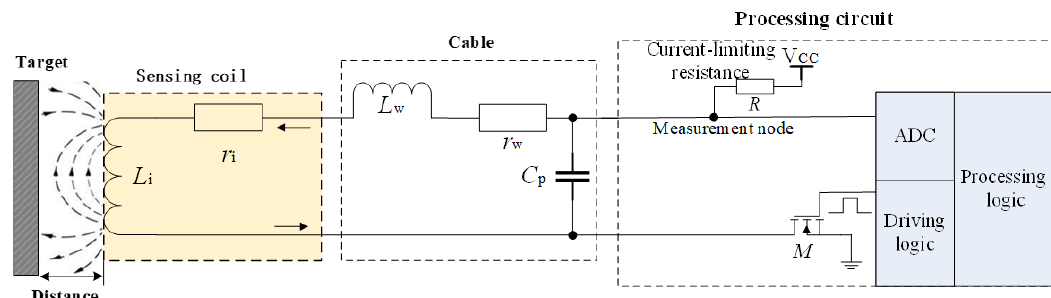
Figure 1. Block diagram of single-sensor-coil structured inductive proximity sensor (IPS).